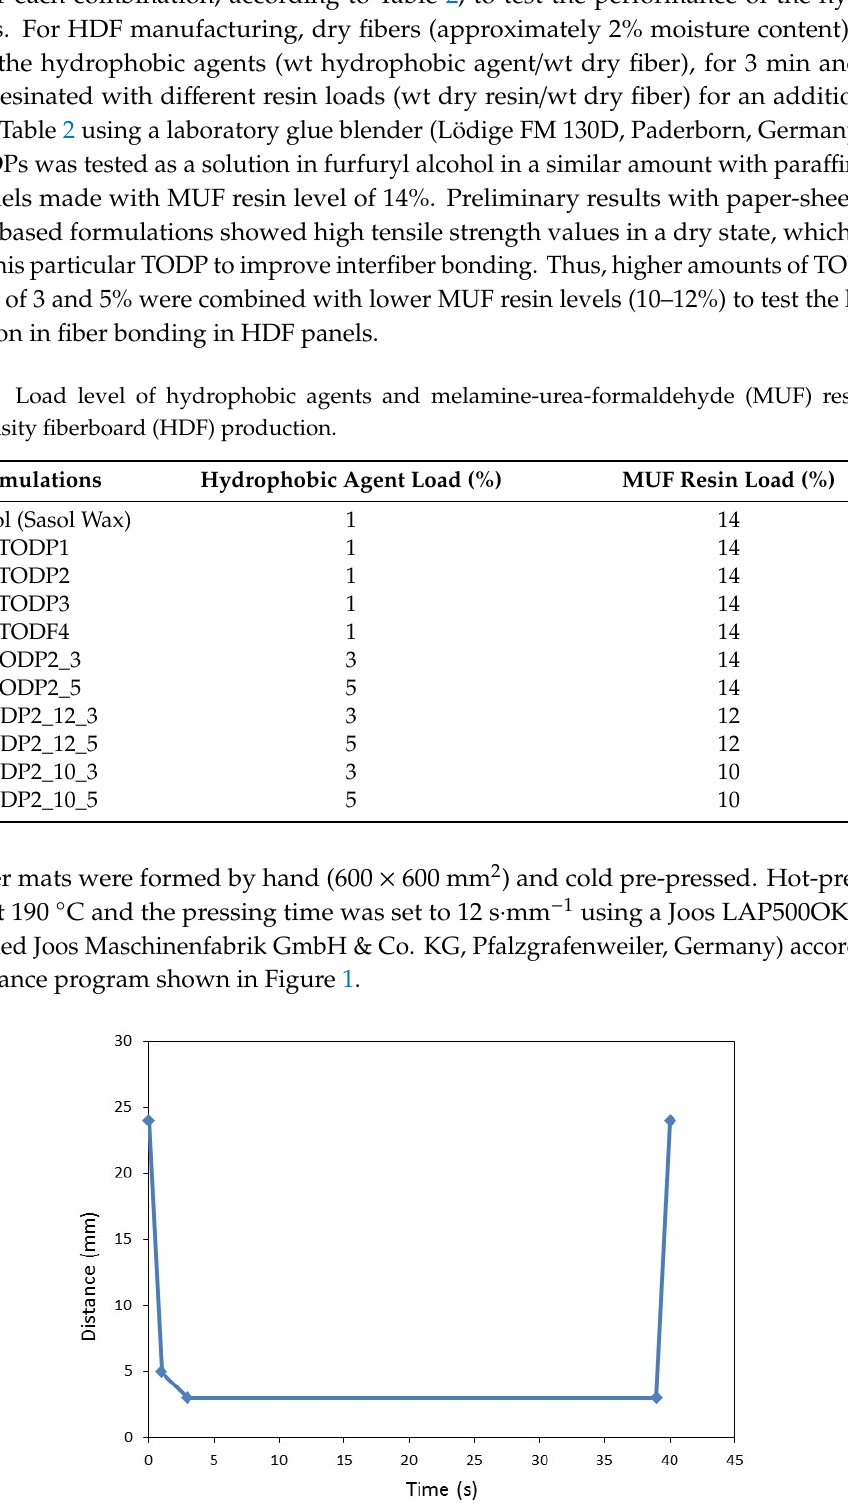
Figure 1. Pressing distance program for HDF production.